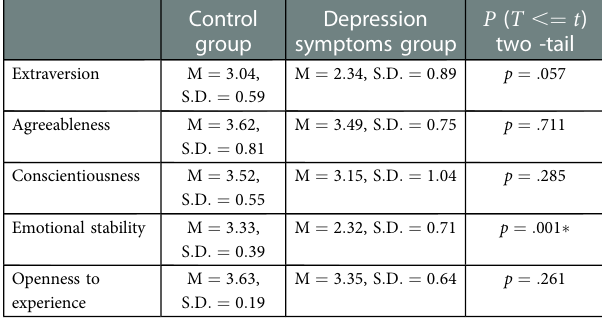
TABLE 3 Big 5 results in each group.